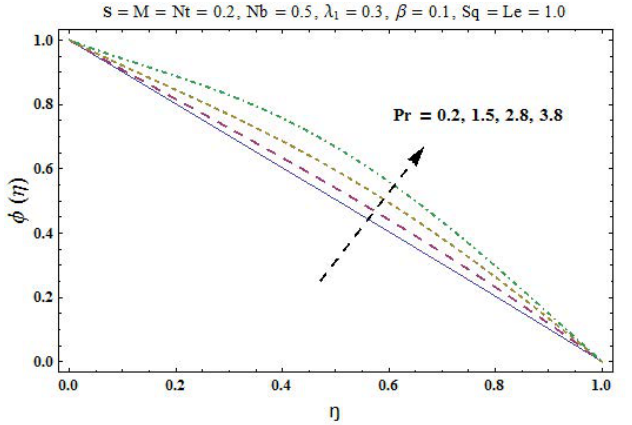
Figure 12. Plots of φ ( η ) for Pr .